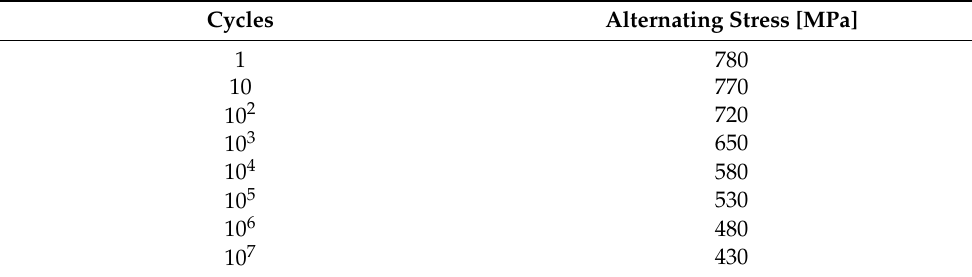
Table 9. For selected composites, cyclic alternating stress, stress ratio R = 0.1. Cycles Alternating Stress [MPa] 1 780